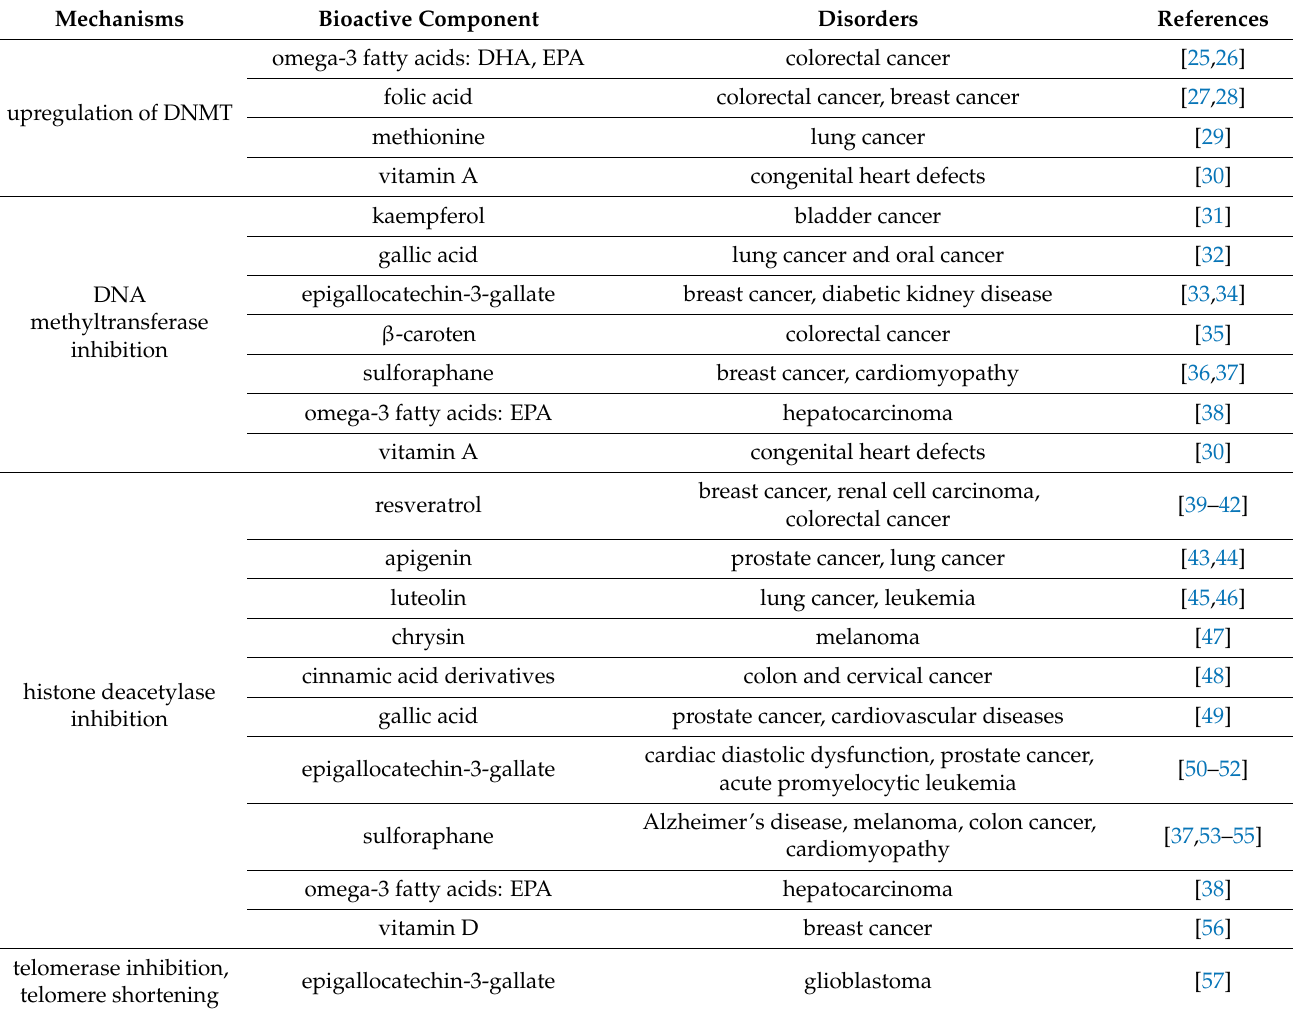
Table 1. Bioactive components of the diet and their role in epigenetic changes in the genome. Mechanisms Bioactive